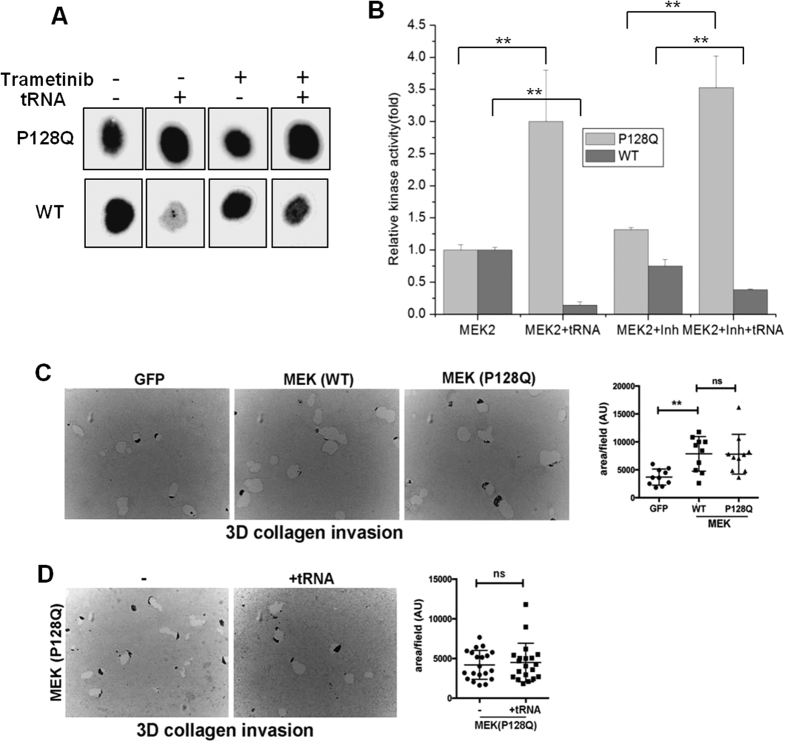
Functional consequences of P128Q MEK2 mutation.(A) P128Q MEK2 mutant was affinity purified for in vitro kinase assay with or without tRNA in the presence or absence of MEK2 inhibitor trametinib (inh). Wild type MEK2 was included as controls. (B) MEK2 kinase activity was quantified, and normalized relative to the kinase activity in the absence of tRNA and trametinib inhibitor. Kinase assays were performed in quadruplicate, and error bars represent standard deviations. **indicates P < 0.05 relative to kinase activity without RNA. (C) CD18 cells were transfected with the plasmids of GFP, wild-type MEK, and MEK (P128Q) mutant. The cells were then grown in 3D collagen CD18 cells and treated with EGF (20 ng/ml) for 3 days to induce invasion. The collagen gels were fixed in formalin, embedded in paraffin and sectioned. The collagenolytic paths generated by invading cells were quantified and relative invasion in 3D collagen was determined. **indicates P < 0.05 relative to WT MEK2, ns indicates no significant difference. (D) CD18 cells were transfected with 0.5 μg plasmid of MEK (P128Q) and co-transfected with tRNA (1.25 μg). The cells were then grown in 3D collagen, treated with EGF and the relative invasion in 3D collagen was analyzed. The results are representative of three independent experiments. The y-axis of the graphs in (C,D) are normalized to each parallel performed experimental series (A. U. = arbitrary units).